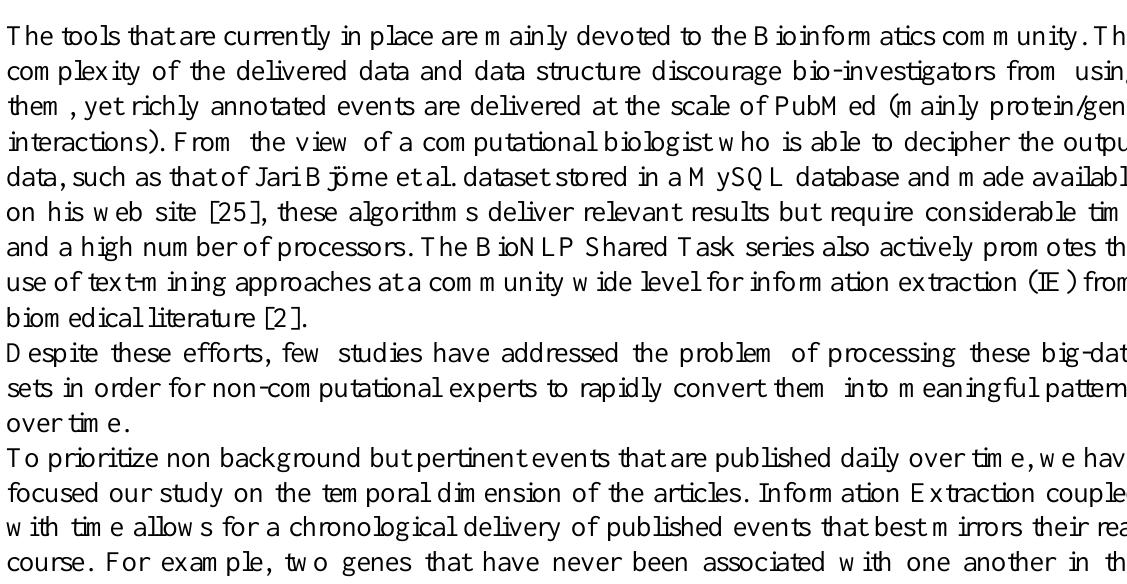
Figure 1. Screen-shot of ali-baba outputs for query